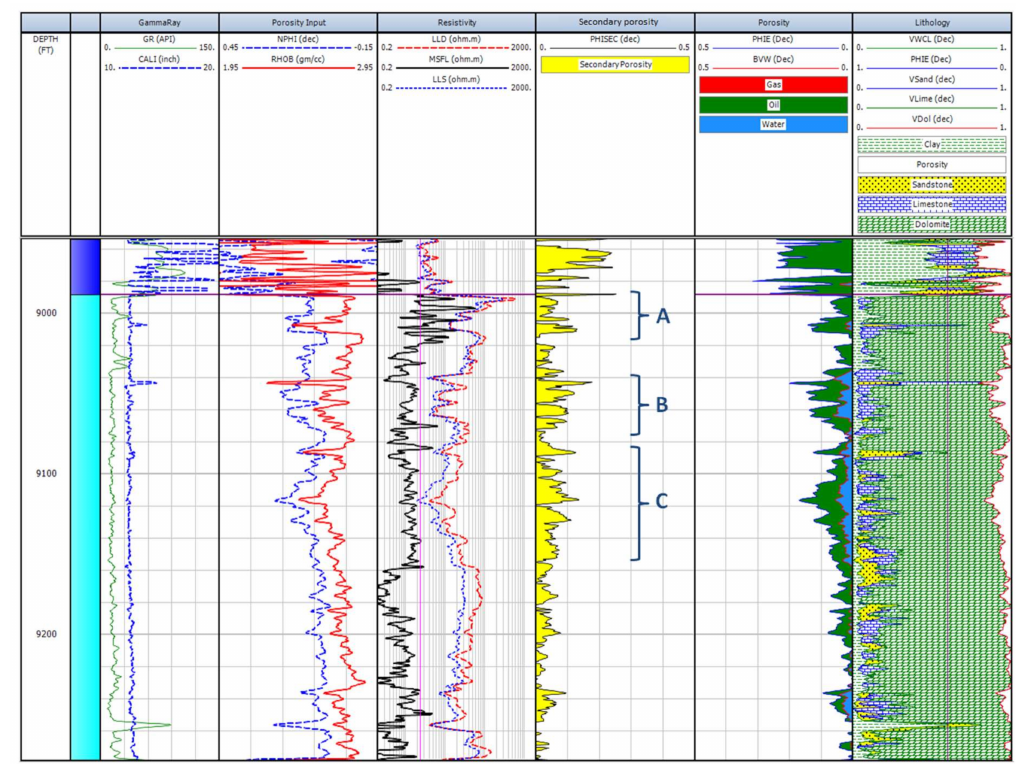
Figure 4. Analysis of well logging data for N.Alamein-6X showing high secondary porosity in the Alamein Formation, where zones with greatest secondary porosity are labeled A–C. Secondary porosity, fluid composition and lithology were derived using the same approach as described in the subscription for Figure